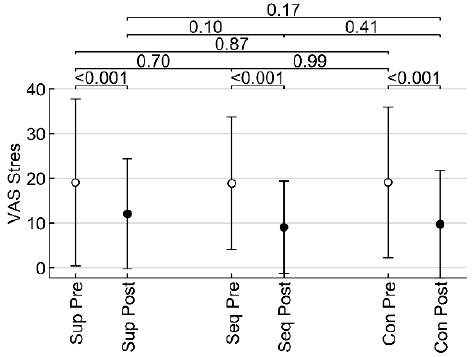
Figure 6. Influence of low-frequency sound on stress assessed by means of visual analogue scale in pre/post measures. Sup—placebo supine; Seq—sequentially dosed amplitude; Con—continuous amplitude. The values displayed above the clips are p -values of Fisher’s LSD tests.